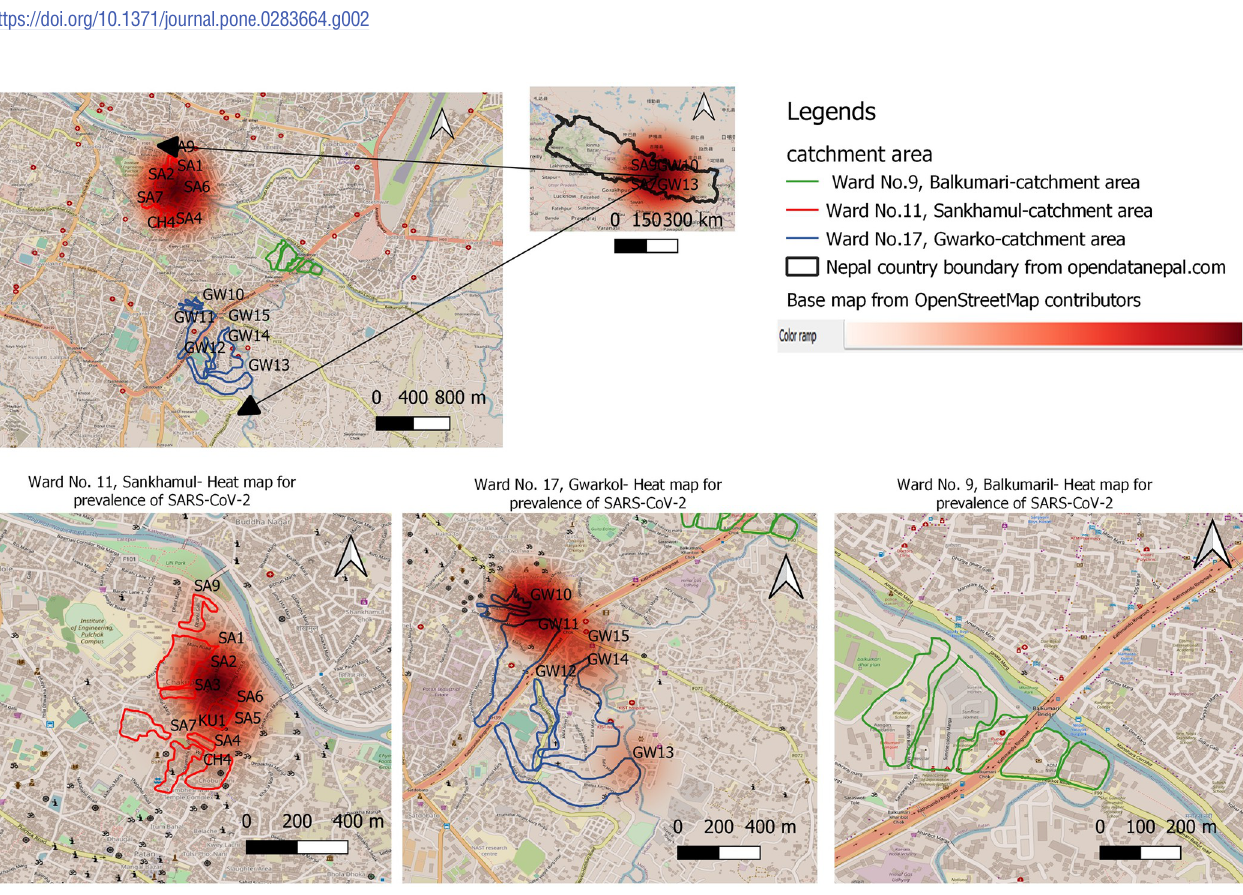
Fig 3. SARS-CoV-2 infection heat-map of three sampled wards (11, 9, and 17) of the Lalitpur Metropolitan City (Kathmandu valley) with predicted SARS-CoV-2 prevalence per 1000 people in sewage samples. The map was created using QGIS v3.16 s [36]]with a base map from the OpenStreetMap contributors. The QGIS heat map plugin assigned the gradient with a max score of one and a minimum of 0.